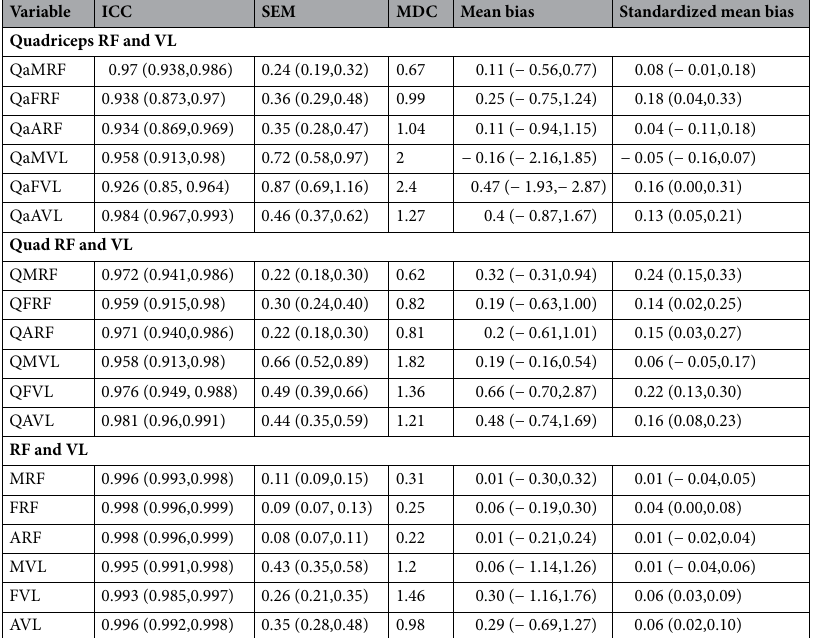
Table 2. Intra-class correlation (ICC) standard error of measurement (SEM) and standardized mean difference with 95% compatibility interval. Mean bias with limits of agreement set to ± 1.96 standard deviations and minimal detectable change (MDC). Values are displayed in cm 2 with standardized mean bias being displayed in SDs. All values calculated for m. rectus femoris (RF) and m. vastus lateralis (VL) comparing investigator1 and investigator2. “Manual” (M), “Fixed pixels” (F) and “Automatic” (A) outline-finder starting points. “Quadriceps” (Qa), “Quad” (Q) and separate image modes were